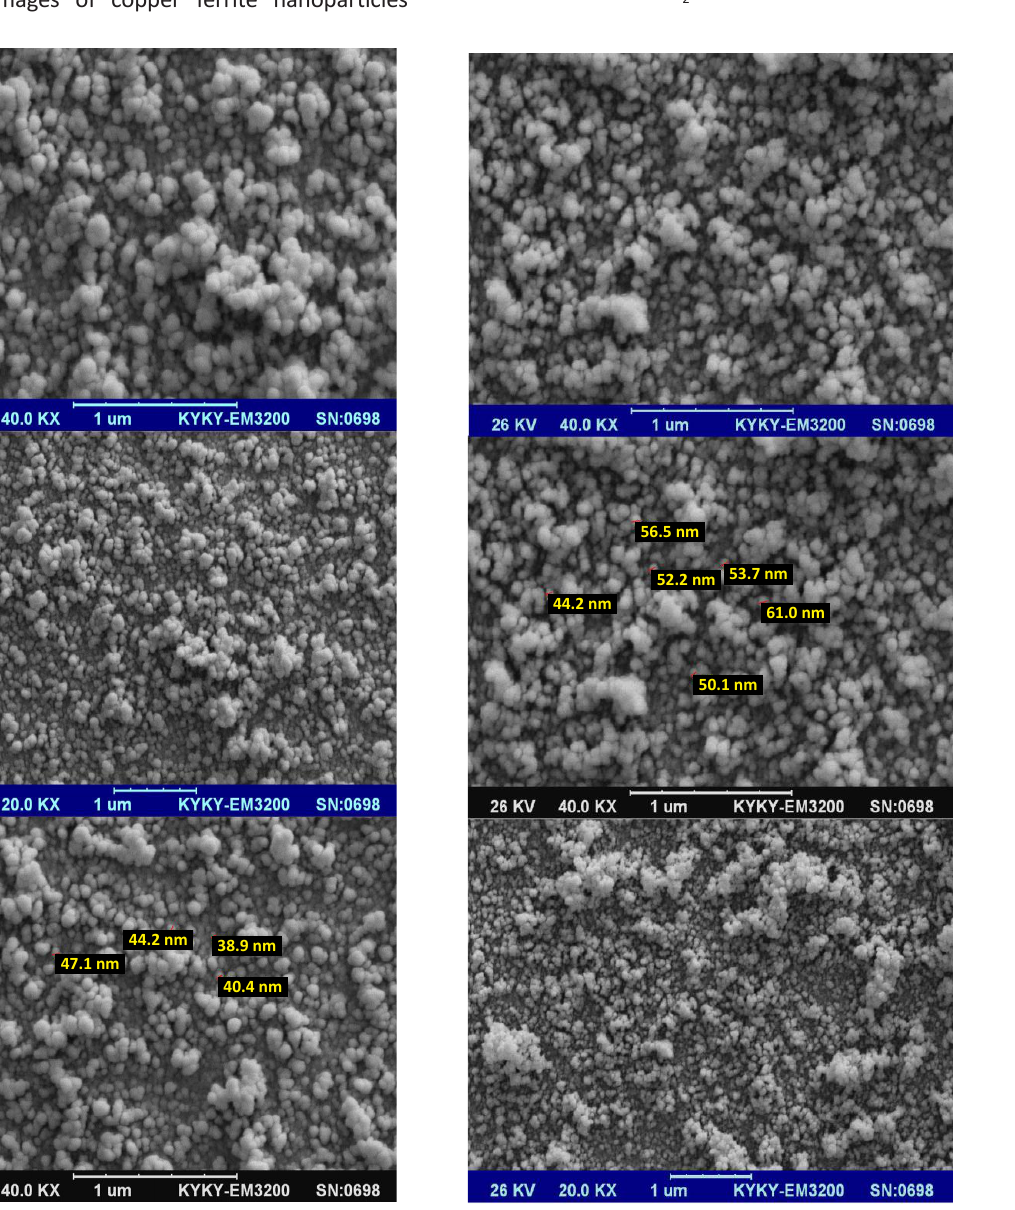
Fig. 3. SEM images of CuFe